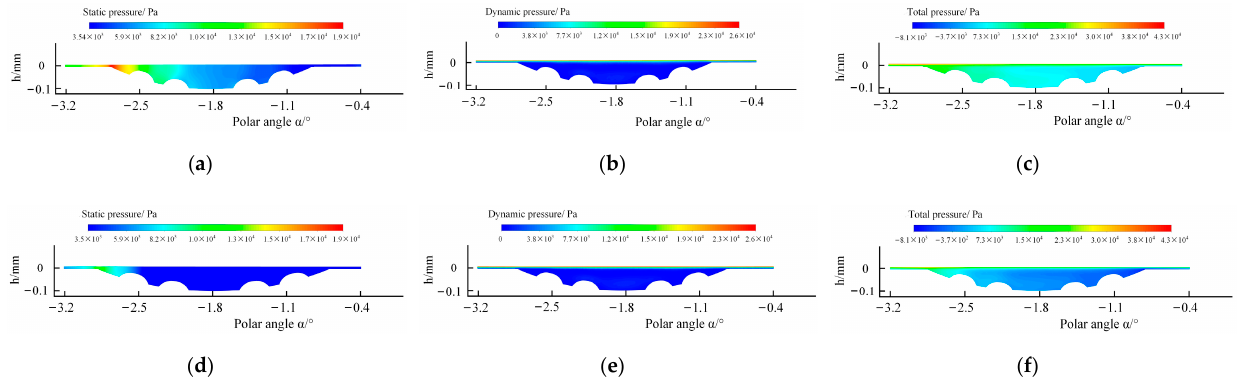
Figure 10. Pressure contours of the single circular pit with the radius of R 2 = 32 mm with and without cavitation. ( a ) Contour of static pressure introducing cavitation effect; ( b ) Contour of dynamic pressure introducing cavitation effect; ( c ) Contour of total pressure introducing cavitation effect; ( d ) Contour of static pressure without cavitation effect; ( e ) Contour of dynamic pressure without cavitation effect; ( f ) Contour of total pressure without cavitation effect.